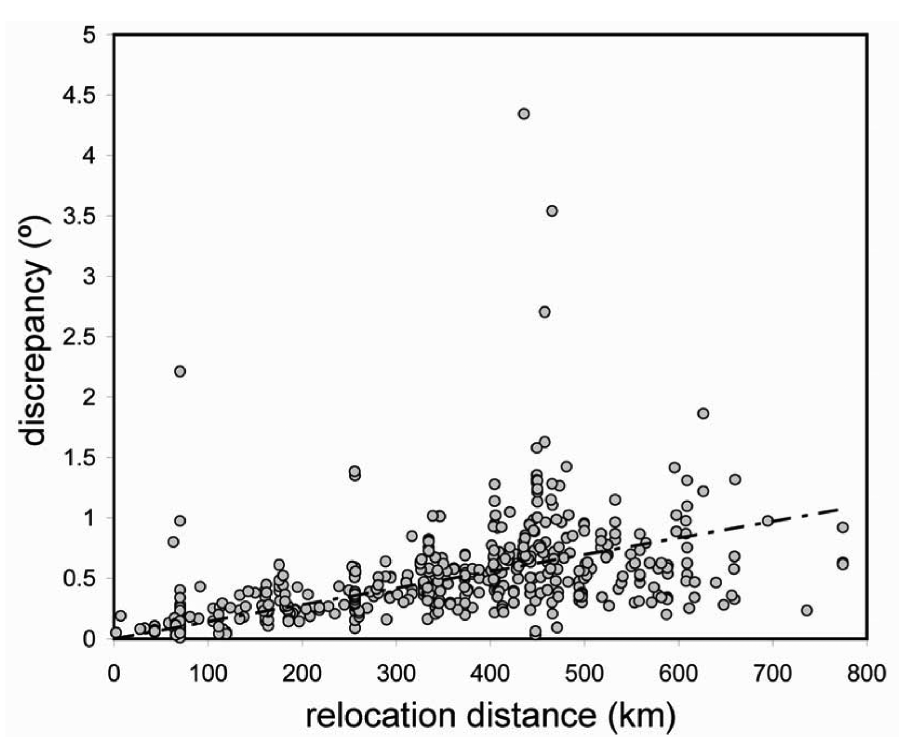
Fig. 3 . Angular discrepancy between the relocated Italian-catalogue data and GUFM1 values at Viterbo as a function of relocation distance. Correlation is